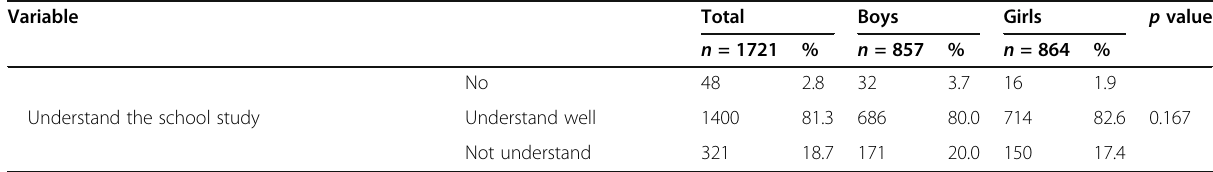
Table 1 Participant characteristics by gender ( n = 1721) (Continued)